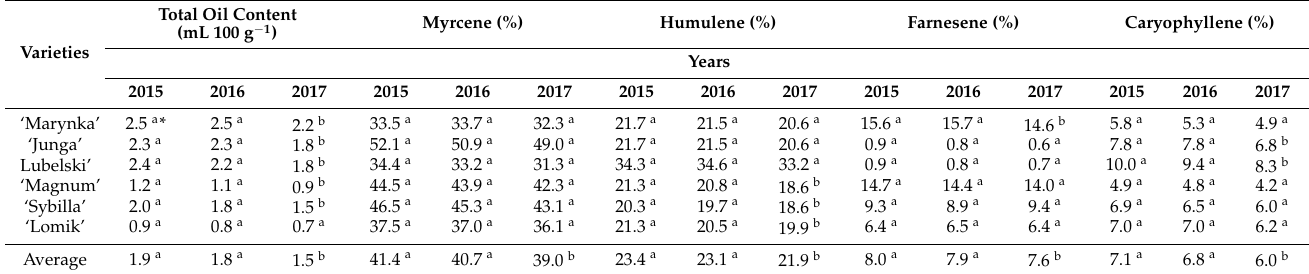
* Letter indicators at the means (significant groups) define the so-called homogeneous (statistically homogeneous) groups. The presence of the same letter index with the means (at least one) means that there is no statistically significant difference between them. The subsequent letter indices a, b, etc., define the groups in ascending